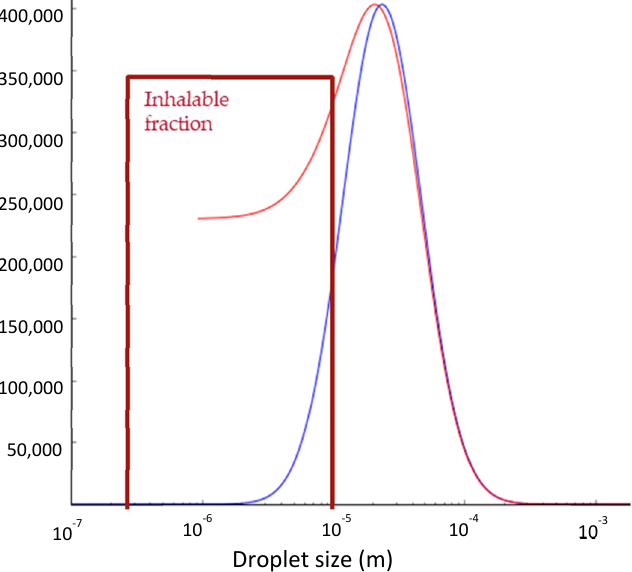
Figure 2. An example of the evolution of the droplet size distribution due to evaporation for relative humidity Φ = 0.9, air temperature T = 300 K, and water flow rate = 2.2 L/min. The blue curve illustrates the number of droplets of each size emitted by the showerhead, and the red curve shows the number of droplets of each size that the model predicted at a distance of 2 m from the showerhead. The red rectangle highlights the pronounced evaporation effect on water droplets with a starting diameter of 10 μ m.